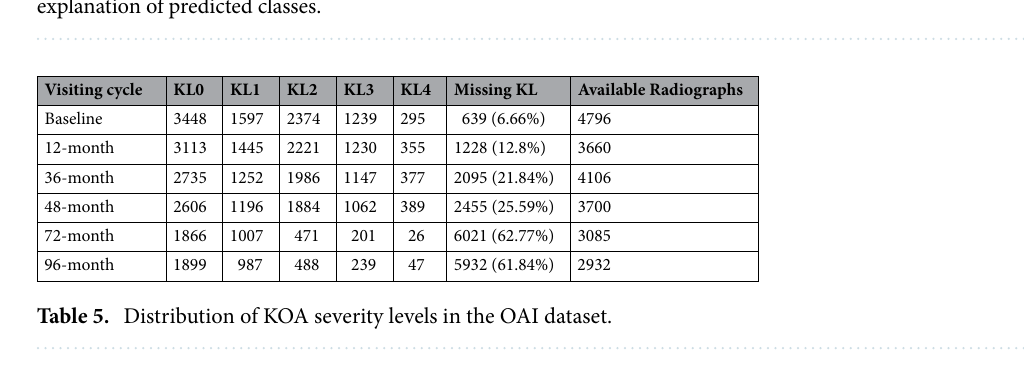
Figure 5. Proposed pipeline for workflow. ( a ) Data concatenation for baseline visit and follow-up visits, ( b ) Kneecap area localization, ( c ) Train test validation split ( d ) Data augmentation, ( e ) Ensemble learning, ( f ) Visual explanation of predicted classes.